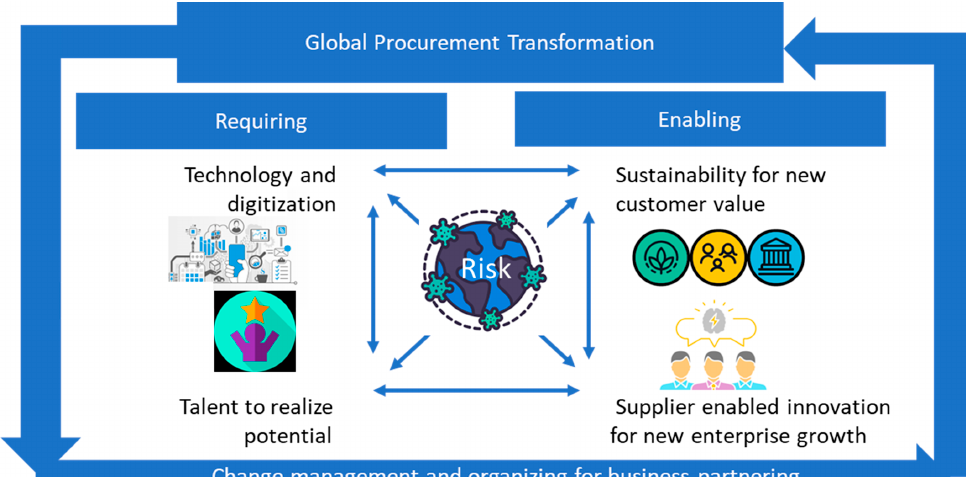
Figure 2. Theory-based course framework based upon van Hoek et al. (2020).